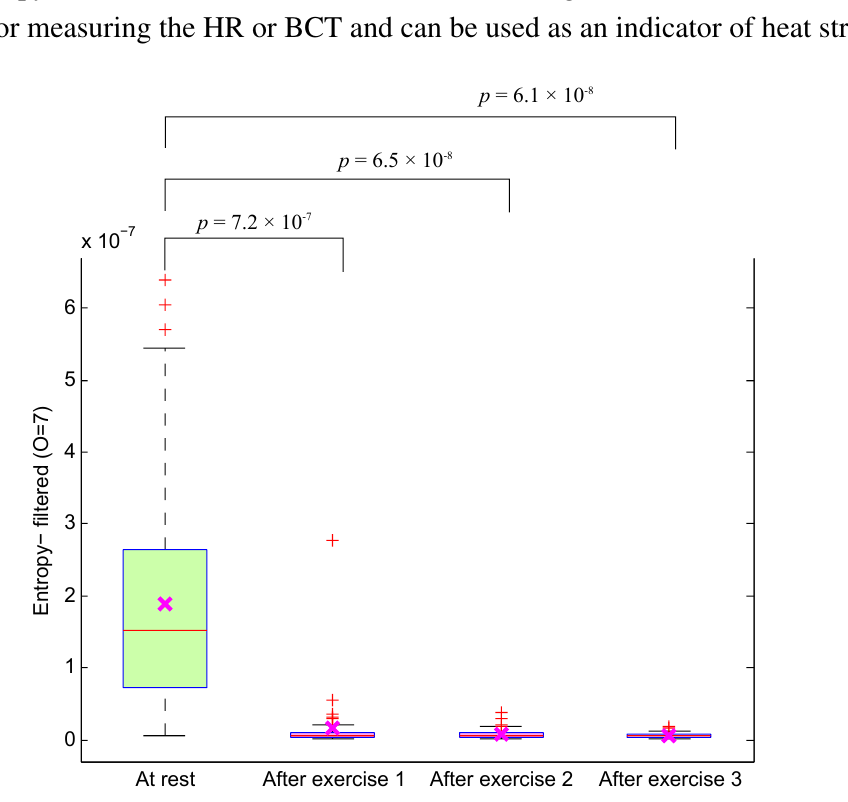
Figure 4. Boxplot of the optimal feature (entropy of the filtered PPG signal) of PPG signals measured before and after simulated heat stress induction. Here, the p -value is calculated using the paired Mann-Whitney test ( p ≤ 0 . 05 was considered